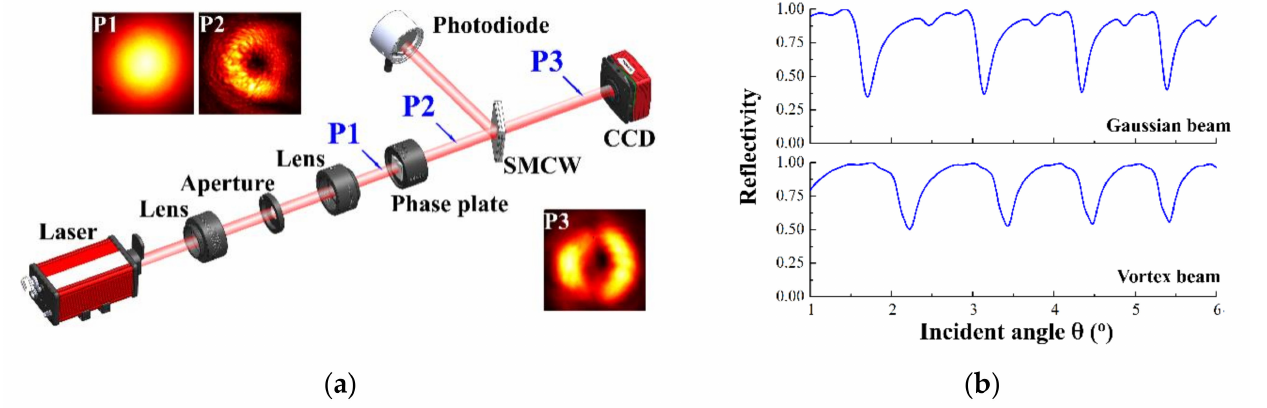
Figure 2. ( a ) Experimental setup of the enhancement and detection of the Goos-Hänchen shift effect via the scattering of a vortex beam on an SMCW structure. Typical light patterns at three different positions (P1, P2 and P3) in the light path are displayed in the insets. ( b ) Comparison of the typical reflection spectra measured by the photodetector between incidences of Gaussian beam and vortex